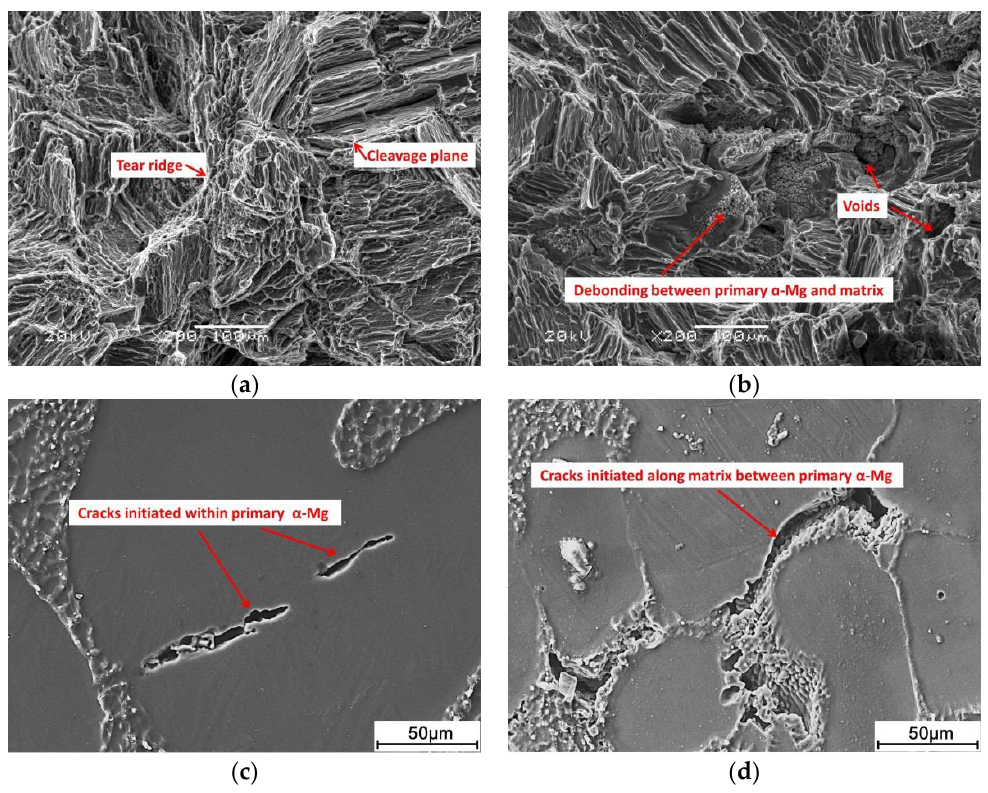
Figure 14. Fractographs ( a , b ) and longitudinal microstructures close to the fracture surface ( c , d ) of the sample with a solid fraction of 0.61 under an injection of 0.5 ( a , c ) and 3 m/s ( b , d ).